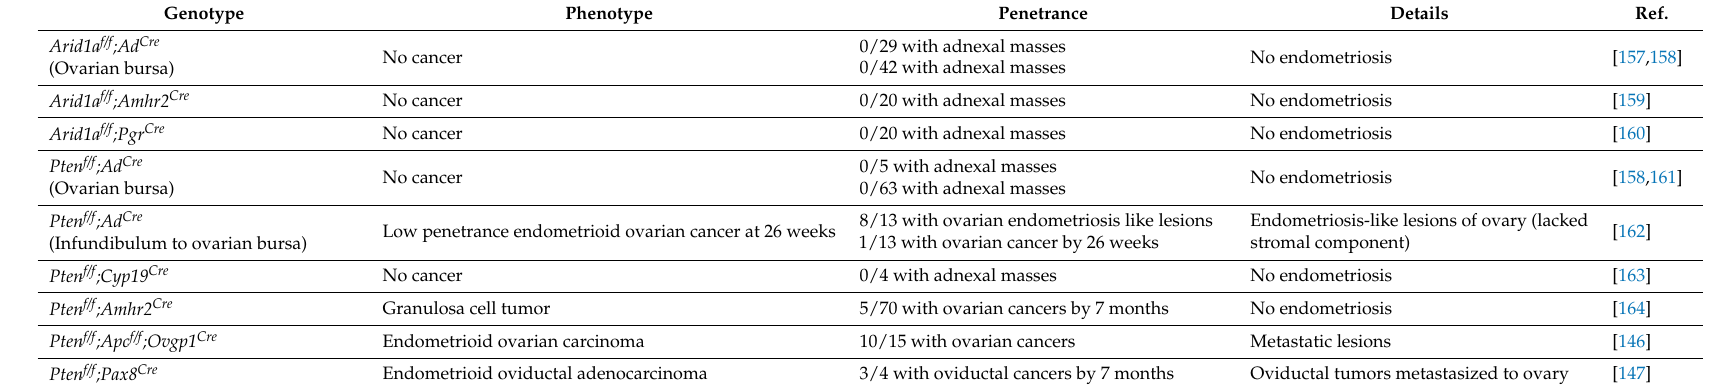
Table 3. Mouse models with implications in endometriosis and endometriosis-associated ovarian